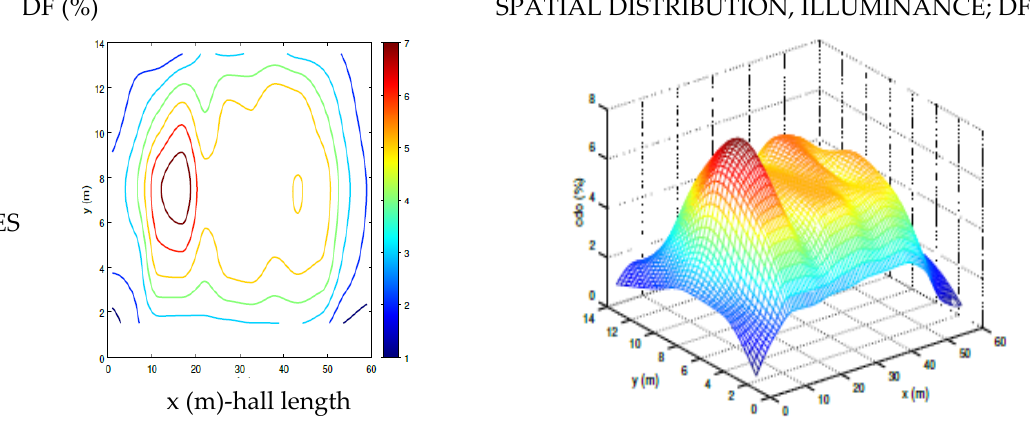
Figure 6. Calculated values of the daylight factor DF (%) in hall from measured values of interior illuminance-current state. Table 2. Recommended reflection factor of surfaces, recommended reflection factor of colors, build- ing material, and optical properties of the interior surfaces of the test hall.